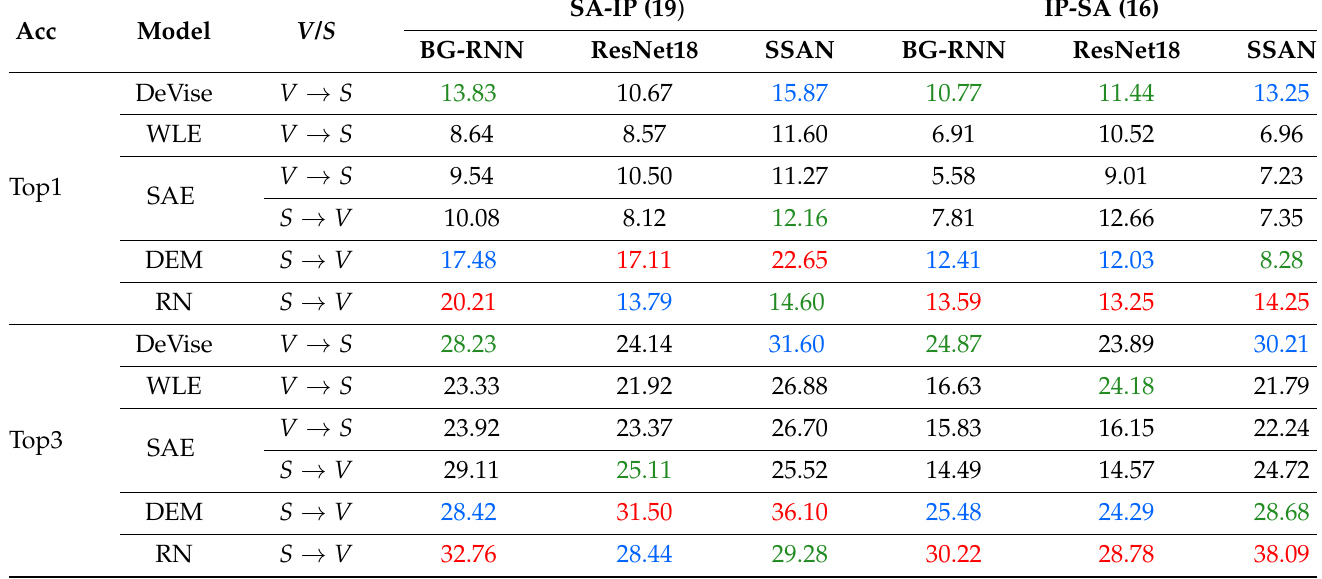
Table 5. Classification performance of multiple comparative methods on GroupA datasets (Case 1 and Case 2) under different visual feature extraction models including the bands-grouping RNN, ResNet18, and SSAN. The best results are shown in red, the blue results represent the second-ranked and the third-ranked results are displayed in